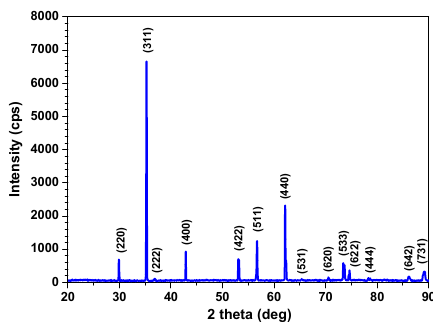
Figure 4. HR-XRD patterns of the electrodeposited magnetite film on Alloy 690 substrate.